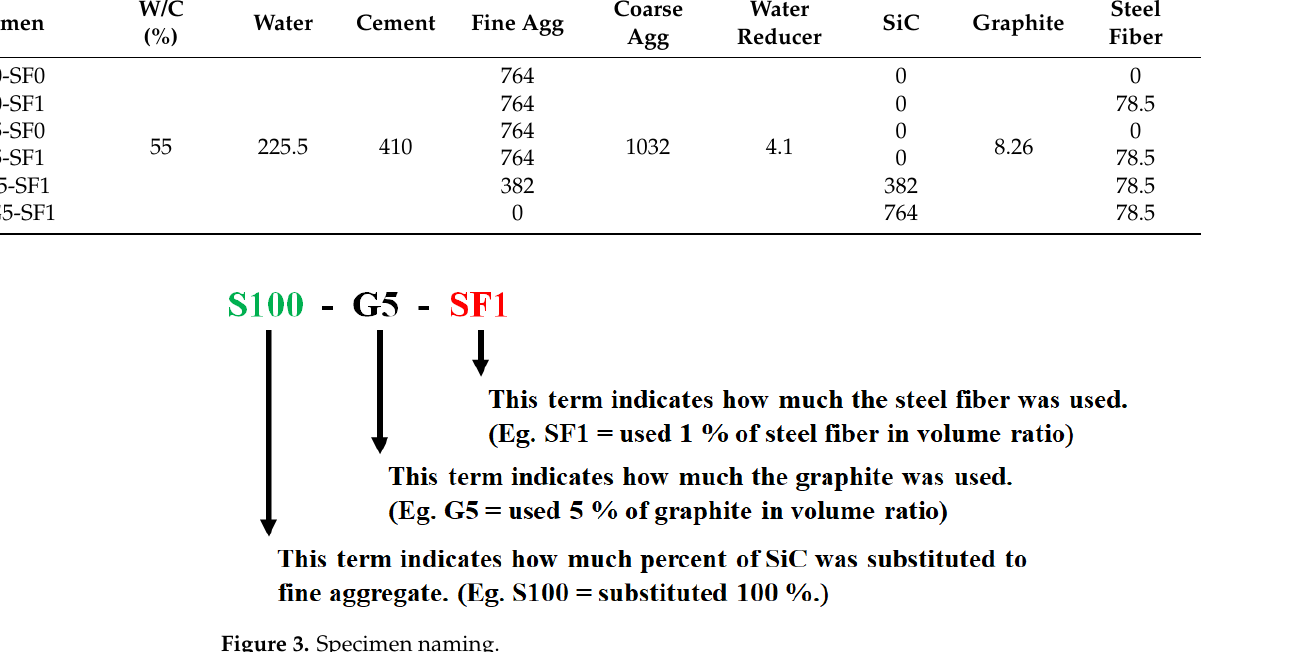
Figure 3. Specimen naming. Figure 3. Specimen